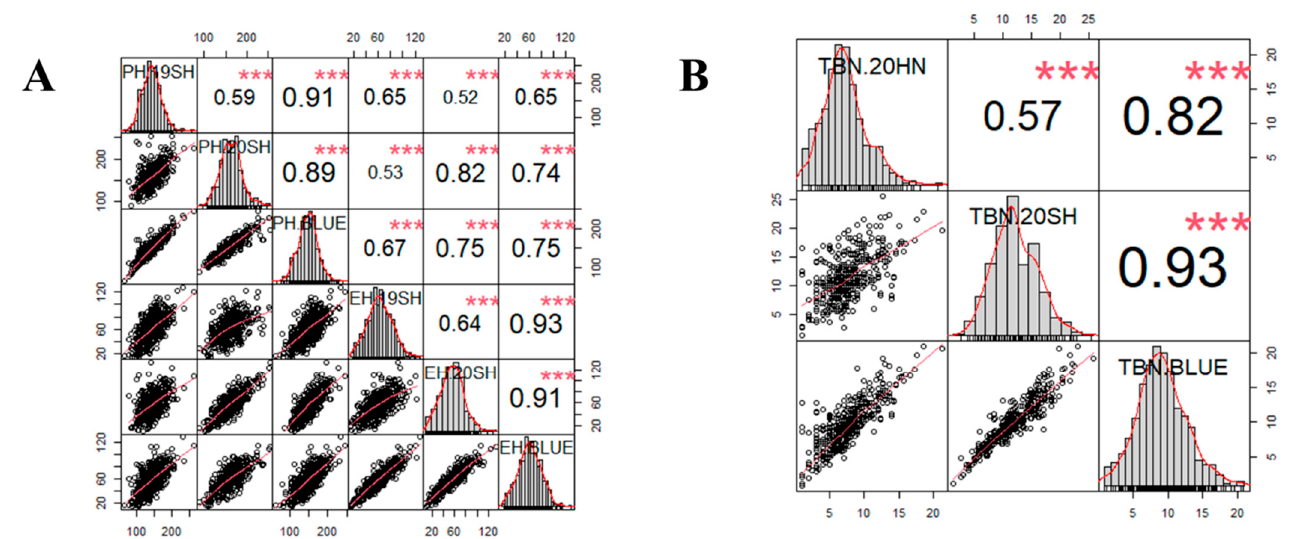
Figure 3. Distributions of and correlations between three relative phenotypic traits. ( A ) Correlation between BLUE and different environments of plant height and ear height. ( B ) Correlation between BLUE and different environments of the number of tassel branches. The frequency distribution histograms of three traits are located on the diagonal line, the area below the diagonal line is the scatter plot of the traits, and the area above is the correlation coefficient between each pair of traits. *** indicate significance at p < 0.001.